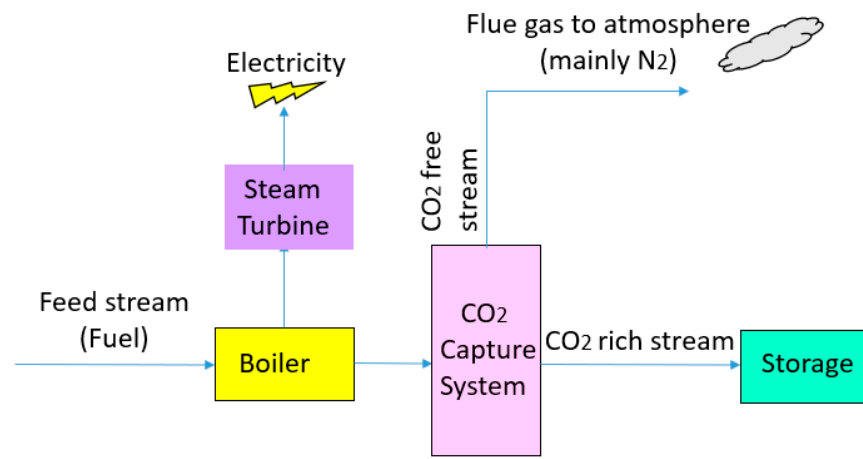
Figure 5. Block flow diagram of post-combustion carbon capture system.